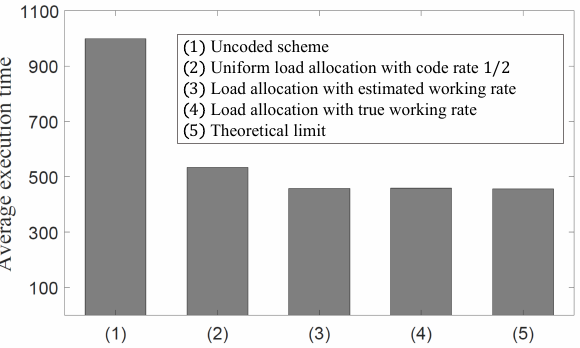
Figure 4. Performance comparison between the uncoded scheme, uniform load allocation with code rate 1 , load allocation in (8) with the estimated working rates, load allocation in (8) with the true 2 working rates, and the theoretical limit of the expected execution